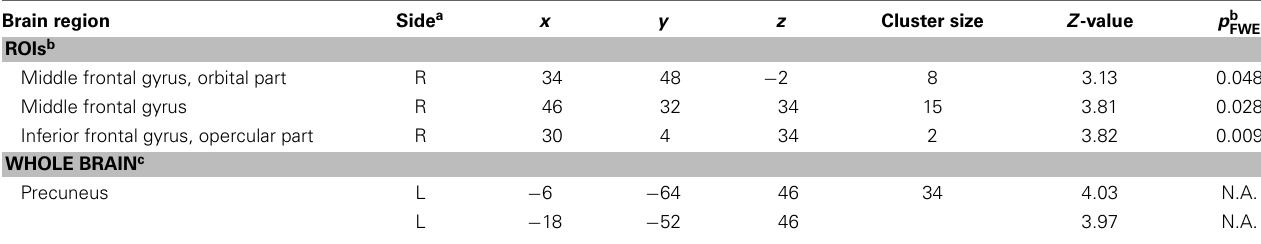
a L, left hemisphere; R, right hemisphere. b Peaks reported are significant at p < 0.05 FWE-corrected on ROI level. c